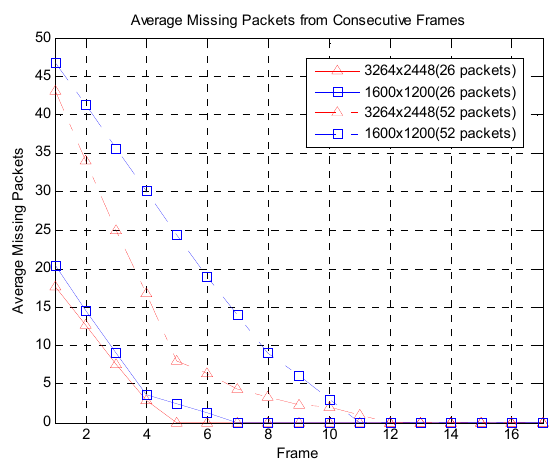
Figure 6. Average missing packets from consecutive frames.